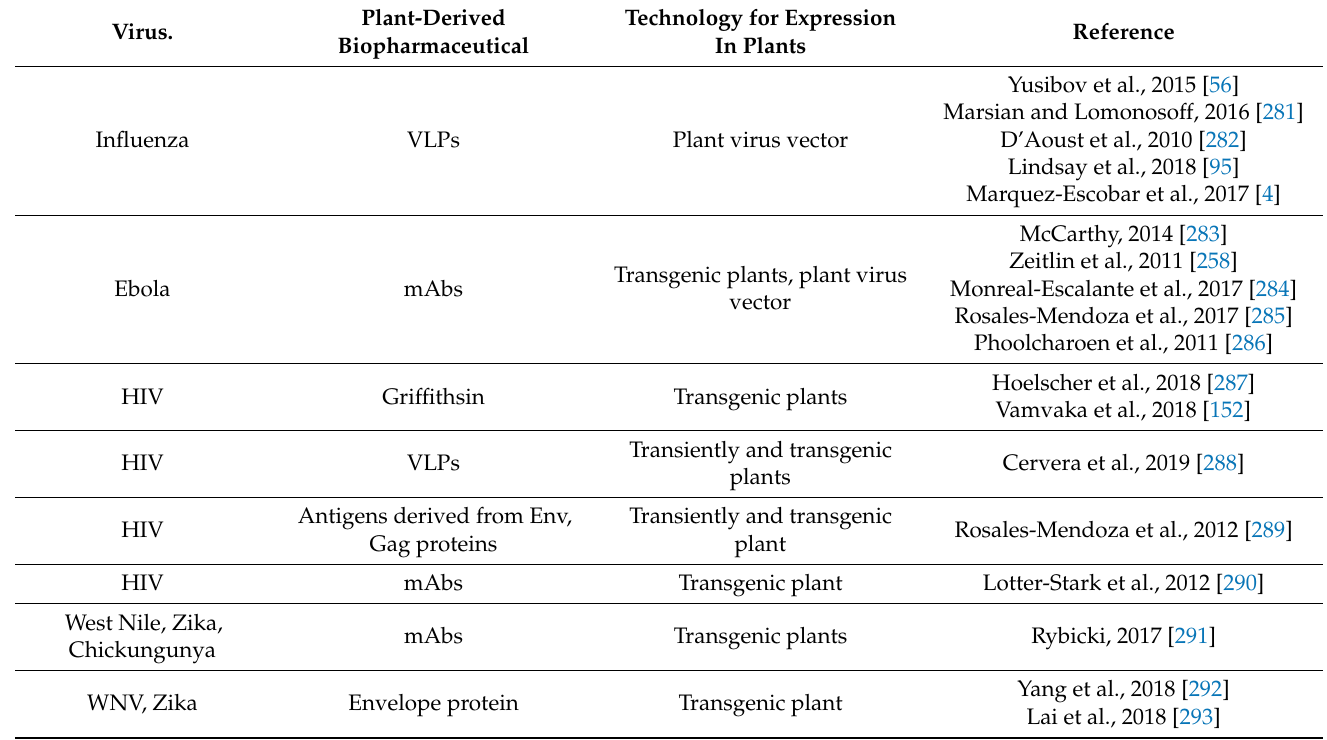
Table 2. Some examples of plant-based biopharmaceuticals against human viruses. Virus.